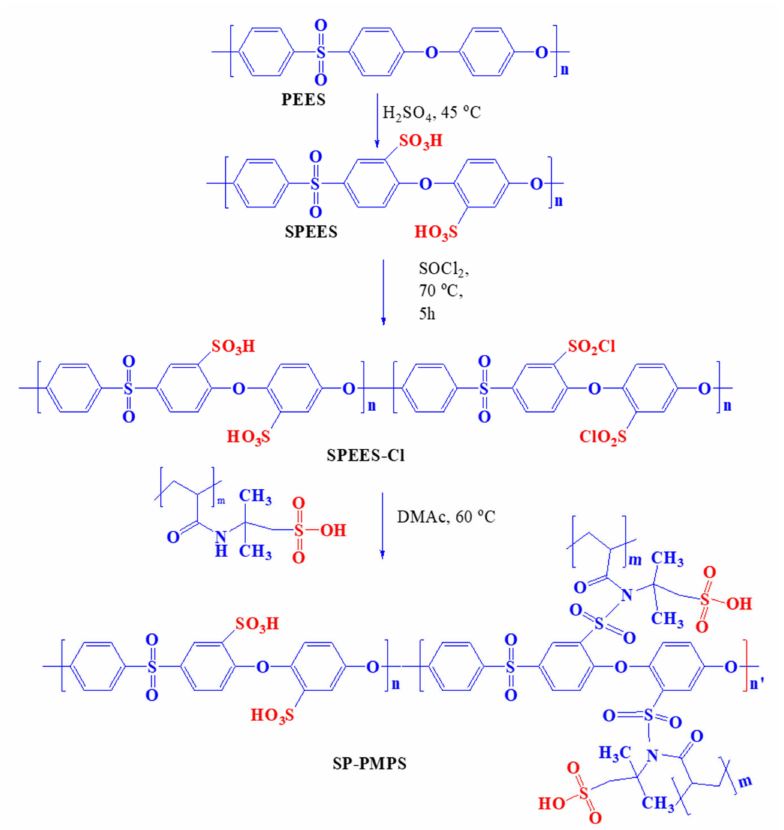
Scheme 1. Reaction scheme showing stepwise synthesis of SPEES (sulfonated poly